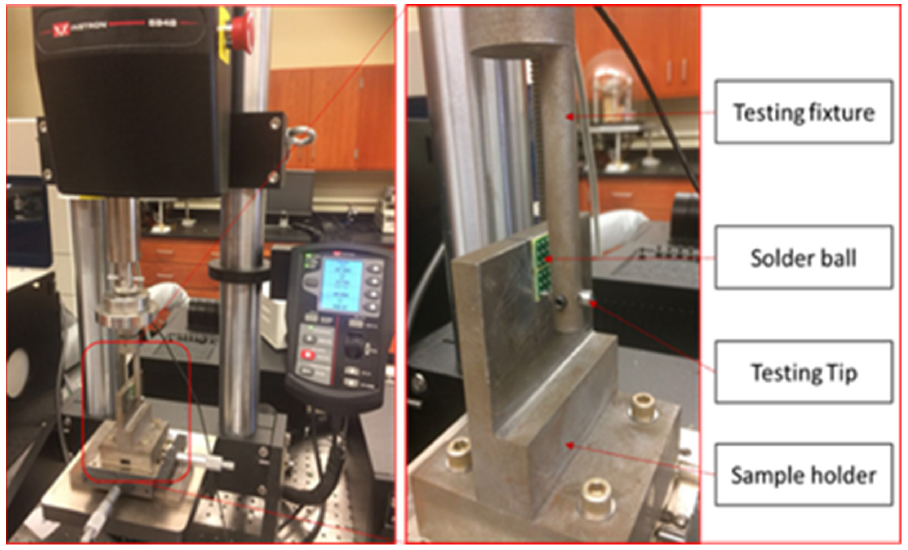
Figure 2. Instron 5948 MicroTester.